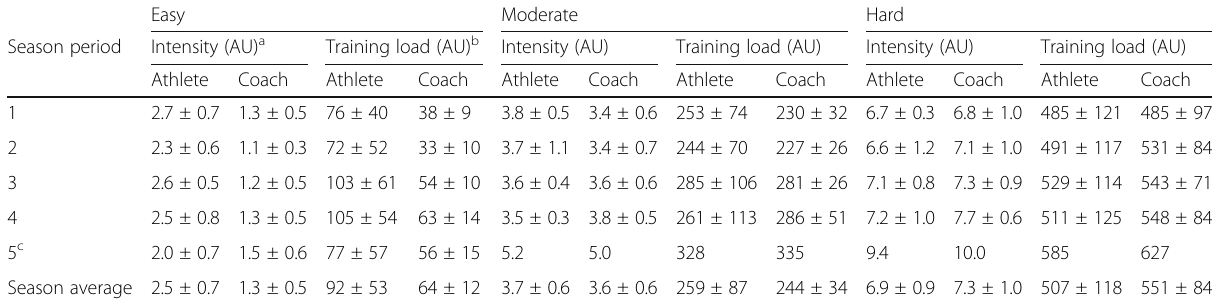
Table 3 Female Runners and Coach ’ s Intensity (sRPE and sRIE) and Training Load (TL RPE ) According to the Season Period and Intended Session Intensity (mean ± SD)